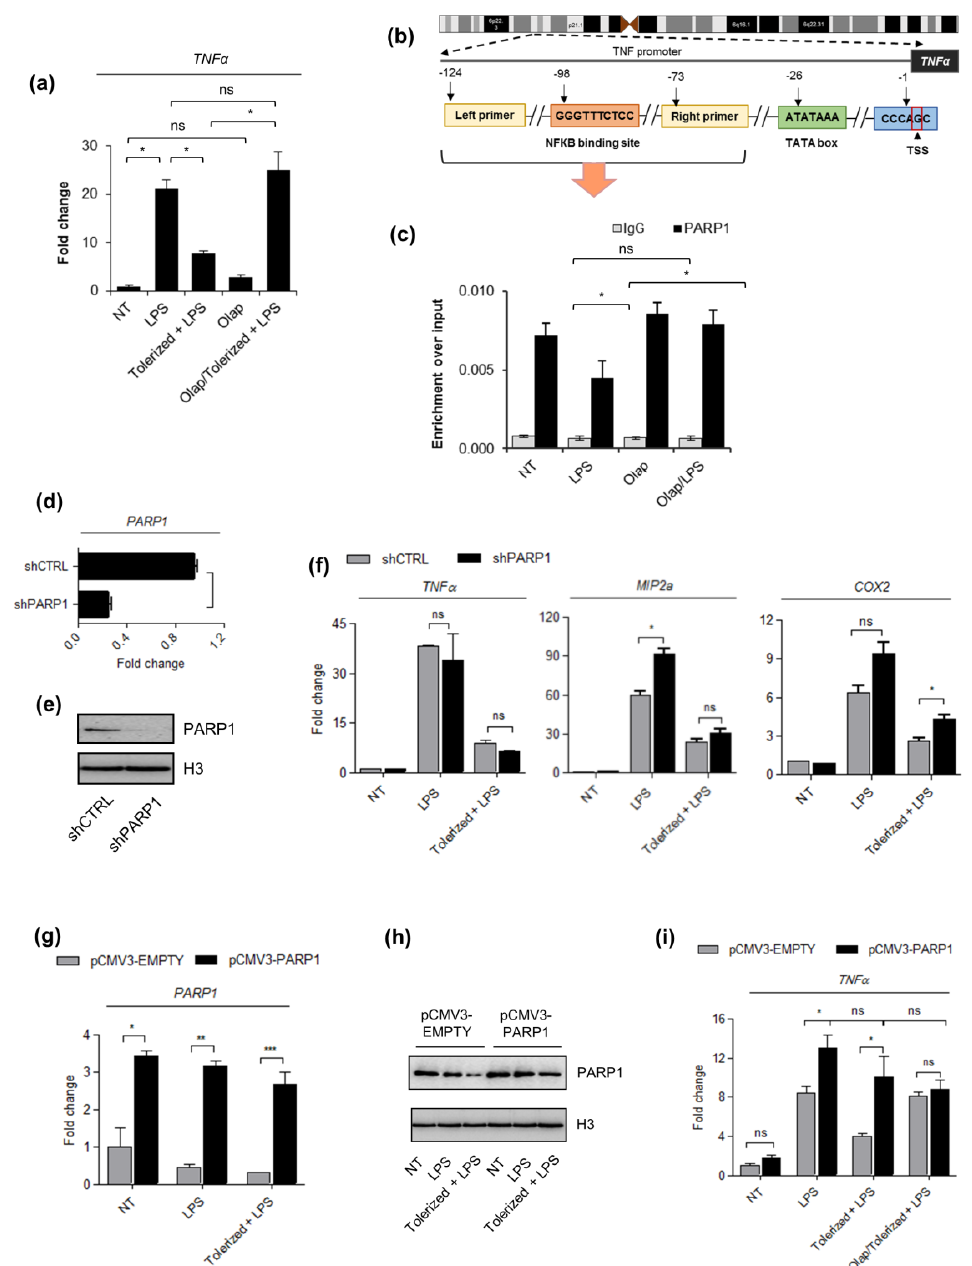
Figure 2. The PARP1 level drives LPS-induced immune paralysis in THP1 cells. ( a ) The induction of tolerance in acute leukemia cells was evaluated based on the TNF- α expression that was quantified by real-time PCR, normalized as median of ACTB and GAPDH , and shown as a fold change with respect to untreated cells. ( b ) The illustration in outlines the human proximal TNF- α promoter and the position of NF- κ B ( − 98) as well as primer (forward: − 124, reverse: − 73) binding sites with respect to transcriptional start site (TSS). The fragment between the two indicated primers was amplified to quantify the immunoprecipitated DNA by real-time PCR. ( c ) The impact of the single LPS dose and olaparib on PARP1 occurrence at the TNF- α promoter was estimated with ChIP-qPCR. ( d – e ) The silencing efficiency of PARP1 in THP1 cells stably transfected with PARP-1 shRNA Plasmid was determined by real-time PCR and western blot, respectively versus corresponding control cells (shCTRL; control shRNA Plasmid-A). PARP1 mRNA was normalized to the median of ACTB and GAPDH , and shown as a fold change with respect to control cells with the normal PARP1 expression. In western blot, H3 was used as a loading control. Full-length western blot images are available in the Supplementary Figure S4. ( f ) The mRNA level of TNF- α , MIP2a